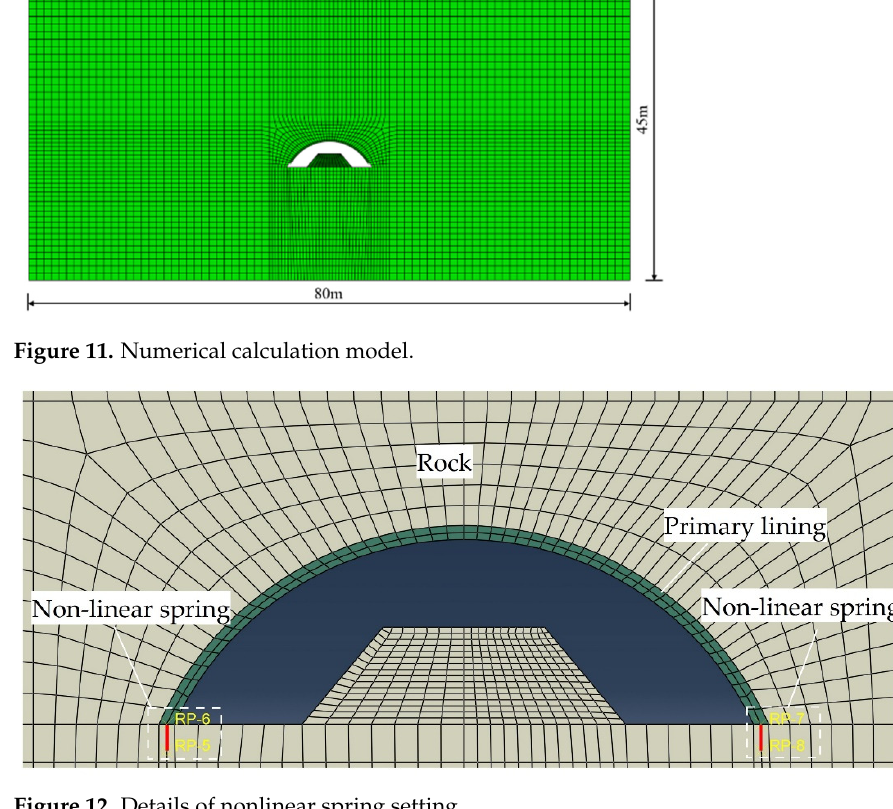
Figure 12. Details of nonlinear spring setting. Table 1. Material parameter table.